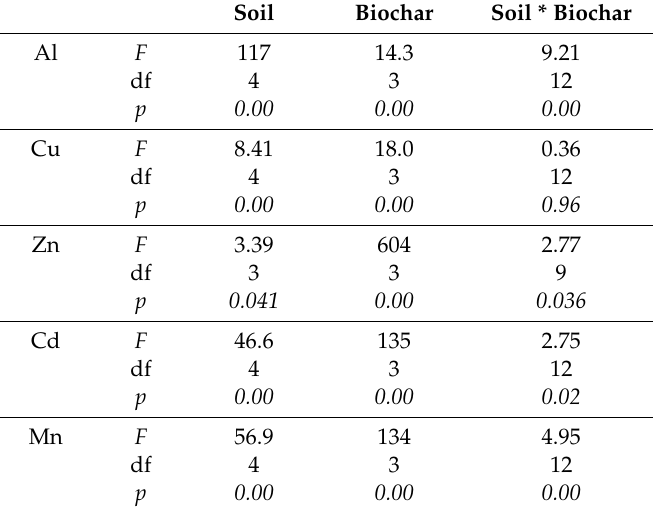
Mn ( n = 4) Table 3. Pearson correlation coefficient of percentage change in the available content of Al, Cu, Zn, Cd, and Mn (content in the control subtracted from biochar treatments) in individual soils with the percentage of change in DOC. Table 4. Multivariate analysis of variance in the change of soil Al, Cu, Zn, Cd, and Mn content (content in the control subtracted from biochar treatments) with interaction and single e ff ect of